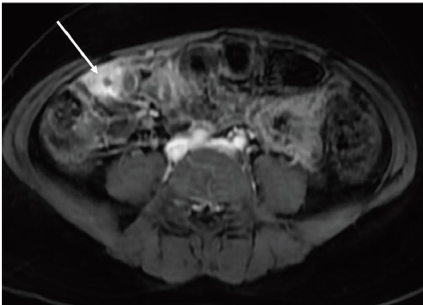
Figure 2: Magnetic resonance enterography performed with in- travenous contrast showed short segment of ileal infammation with wall thickening and enhancement (white